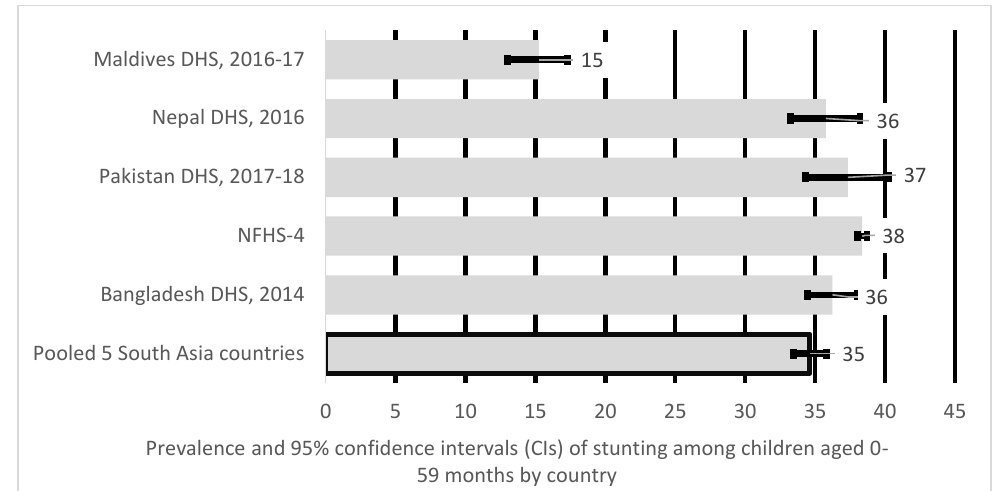
Figure 4. Prevalence and 95% confidence intervals of stunting in children aged 0–59 months in South Asia.